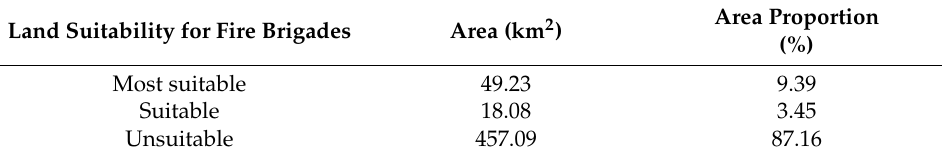
Figure 9. Evaluation of suitability for fire brigades. Table 12. Area and proportion of each suitable zone.